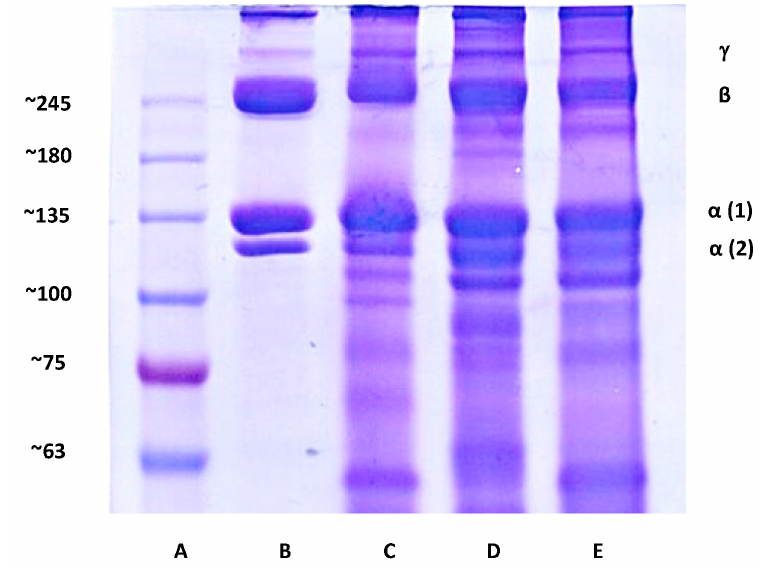
Figure 3. Scanning electron microscopy (SEM) images (( A ) surface and ( B ) cross-section, scale bar: 200 µ m) of a ECM HCl,25 , a ECM GA,25 and a ECM PCA,25.